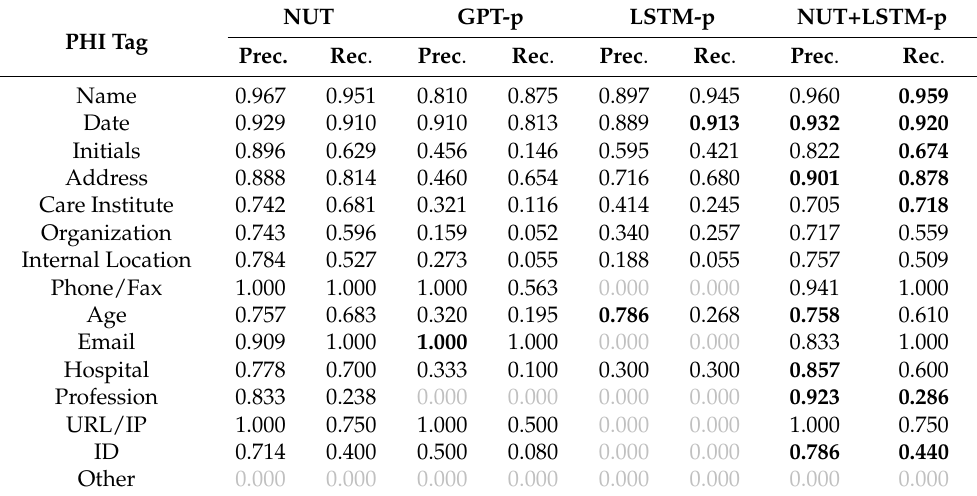
Table 7. Entity-level precision and recall per PHI category. Comparing the baseline ( NUT ) with two models trained and validated on pure synthetic data (LSTM-p vs. GPT-p), as well as the mixed variant (NUT+LSTM-p) where the training set is composed of NUT and LSTM-p, but the validation set is the same as the one used in the baseline (real data). Highlighted values (bold) show improvements over the NUT